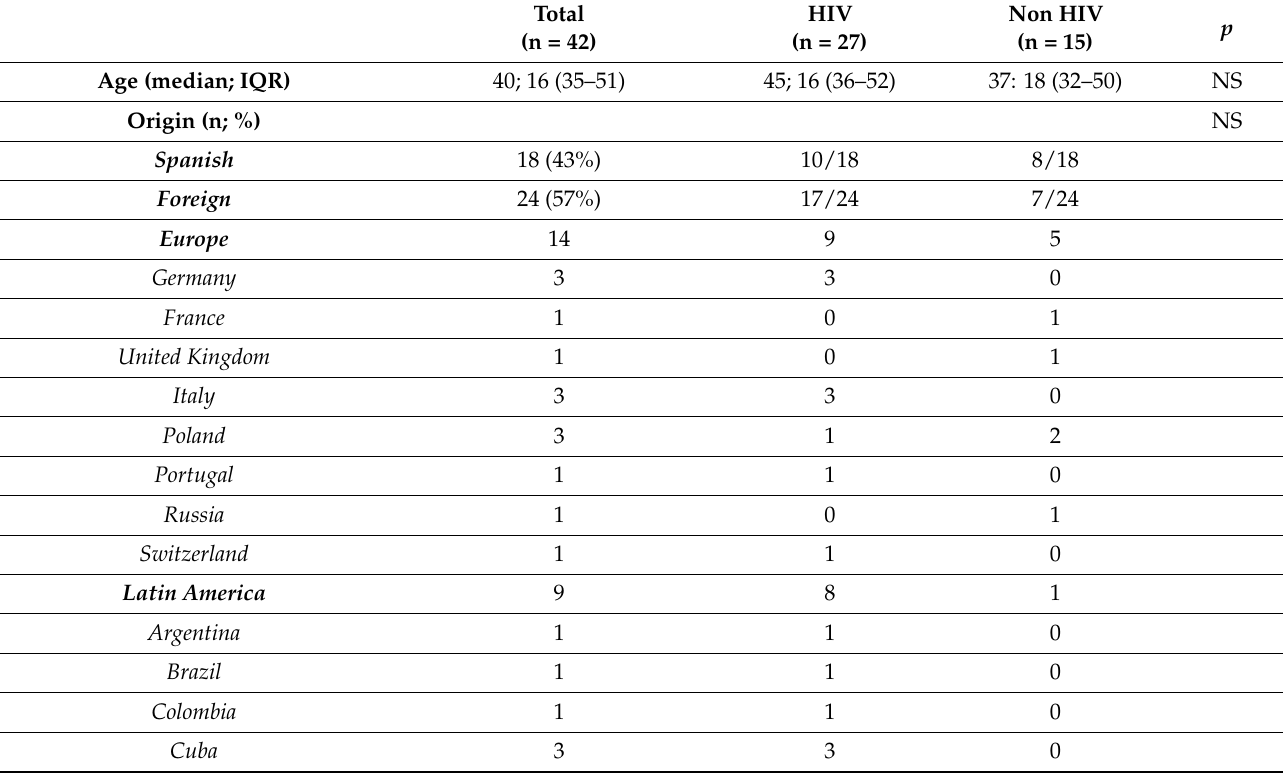
Table 1. Demographic and Clinical Characteristics of persons with